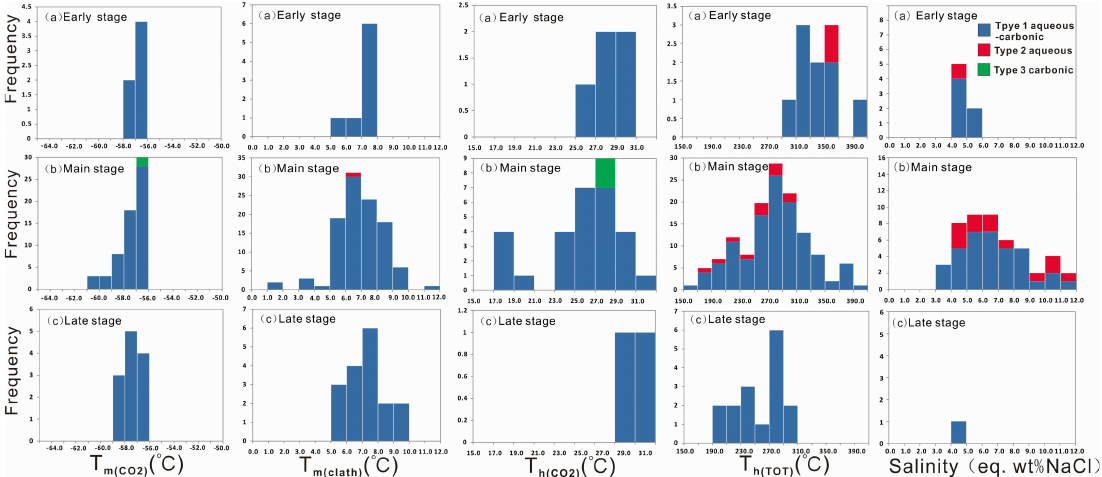
Figure 10. Histograms of the microthermometric data showing the temperatures of T mCO2 , T mclath , T hCO2 and T hTOT and the